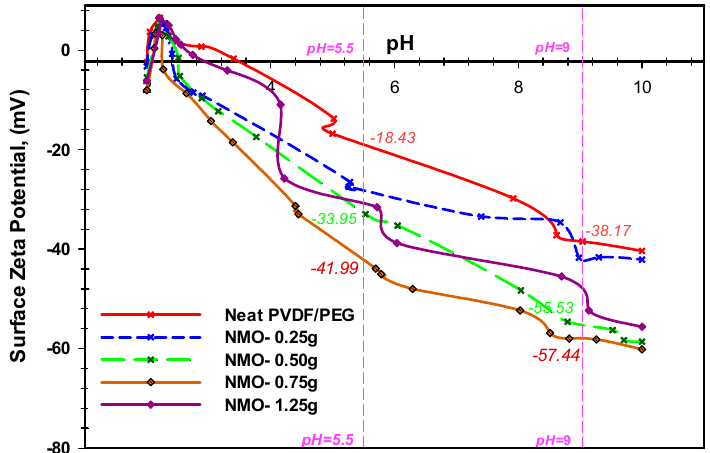
Figure 5. Surface zeta potential of neat PVDF-PEG, and modified Nano-hybrid membranes.